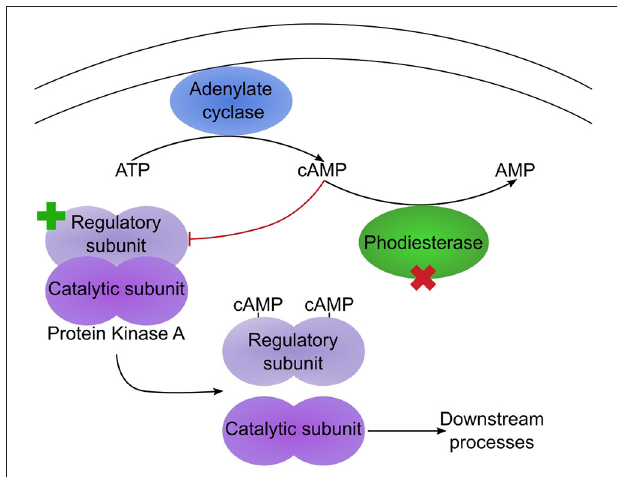
FIGURE 5 | Two mutations potentially affect the same pathway. Simplified diagram illustrating the regulation of protein kinase A (PKA) by cAMP. Under low cAMP condition, the PKA regulatory and catalytic subunits dimerize, leading to an inactive PKA. In Swe1, as the regulatory subunit is constitutively inactive, PKA would be predicted to be permanently active. In Swe2, the inactivating mutation of the regulatory subunit is reverted to wild-type (as indicated by the green cross), so PKA would again come under the control of cAMP levels. Its activity is also regulated by a cAMP phosphodiesterase (PDE), as this converts cAMP to AMP. The PDE bears a non-synonymous mutation in Swe2 (red cross). Assuming that this corresponds to a loss of function, the two mutations would act synergistically, as cAMP would accumulate, thereby accentuating the suppression of repression of PKA activity. Thus PKA would be predicted to be more active in Swe2 (and Swe3) than in Swe1 under the same culture